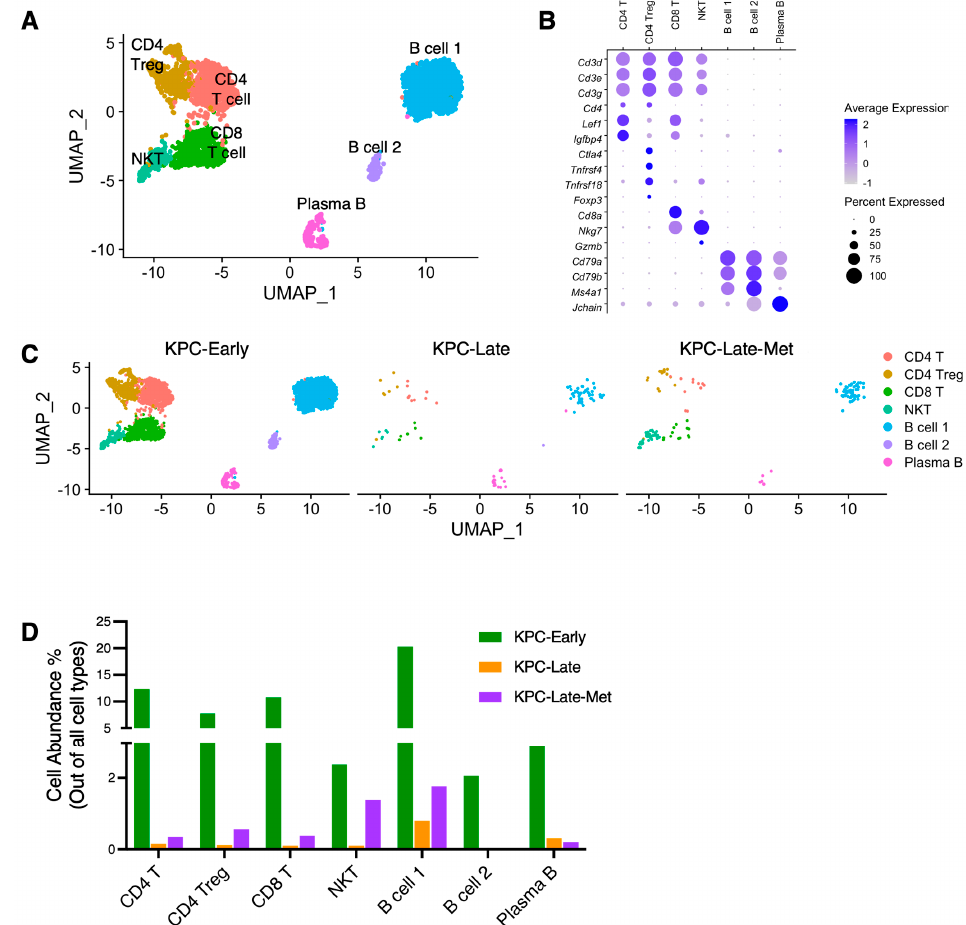
Figure 6. Subpopulation compositions of T cells and B cells in primary tumors and liver metastases. ( A – C ) T cells and B cells from primary tumors and liver metastases are stratified into indicated subclusters in UMAP plot ( A ) based on the various expression profiles of signature genes shown in dot plot ( B ). The temporal alteration of T cell and B cell compositions are compared across KPC- Early, KPC-Late, and KPC-Late-Met groups ( C ). ( D ) The abundance (%) of indicated T and B cell subpopulations across KPC-Early, KPC-Late, and KPC-Late-Met groups.